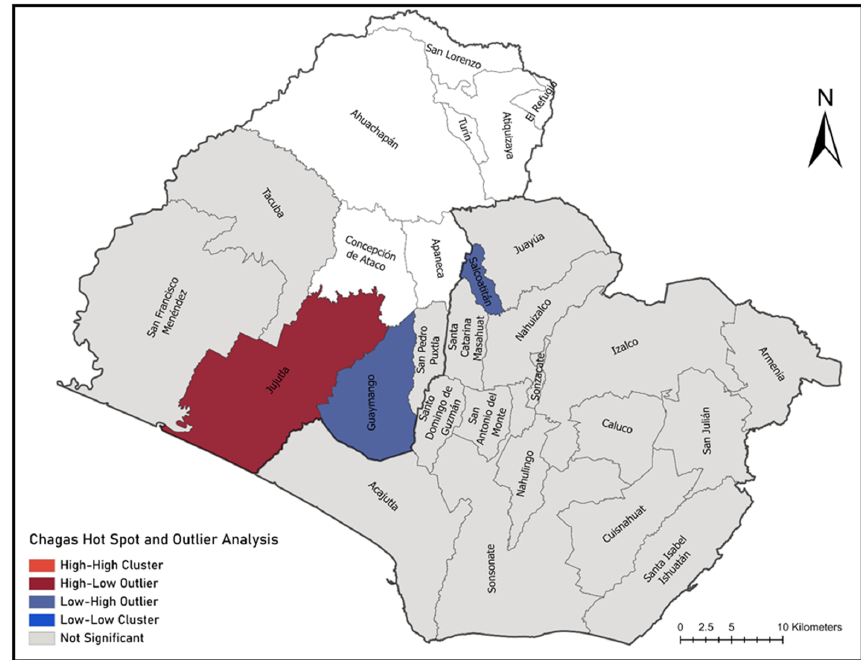
Figure 3. Cluster and outlier analysis of Chagas positive cases by municipality. High-low outliers indicate municipalities with comparatively higher T. cruzi positive prevalence from our participant population, surrounded by municipalities of lower prevalence. Low-high outliers indicate areas of lower T. cruzi positive prevalence from our study population, surrounded by municipalities with comparatively higher